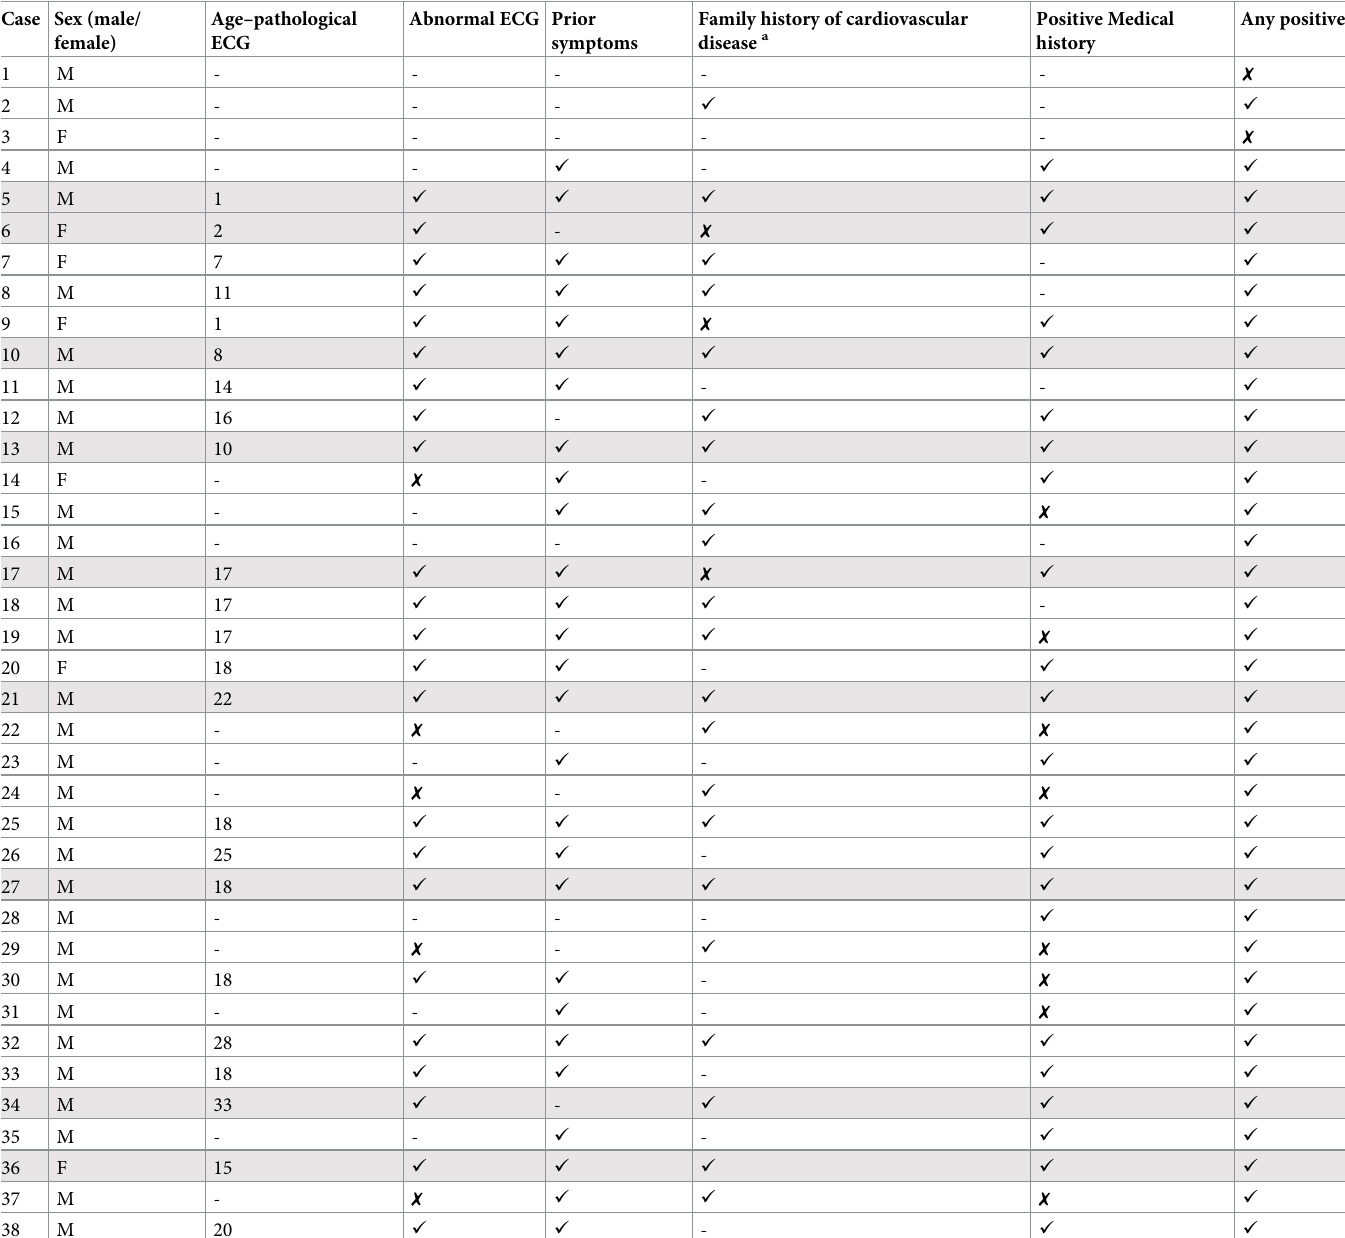
Table 4. Summary of abnormal findings prior to death in young HCM individuals suffering from SCD. Case Sex (male/